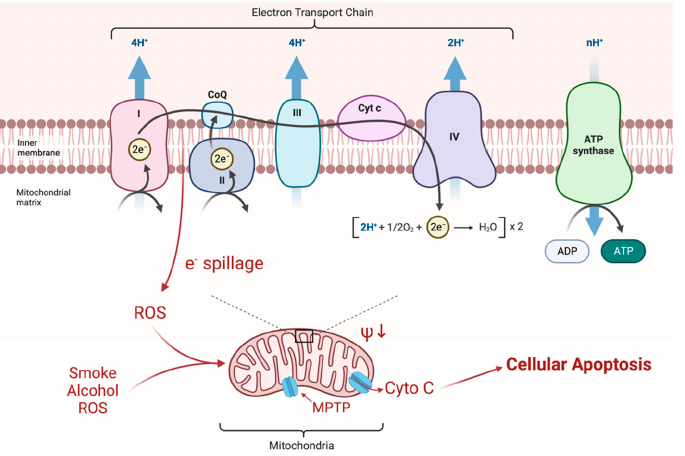
Figure 1. Electrons are transferred along the chain of complexes for oxidative phosphorylation. The energy is largely stored as a proton gradient that is later exploited for the production of ATP. Mutations of Complex I, as seen in LHON, produce a minor impairment of ATP production (about 20%), but also a greater production of ROS (10X) by spillage of electrons at the attempted transfer to Co Enzyme Q10. These ROS change the electrical potential across the mitochondrial membrane which, in crossing a critical threshold, can open the mitochondrial permeability transition pore (MPTP) releasing cytochrome C (Cyto C) and initiating apoptosis of the RGC [26].